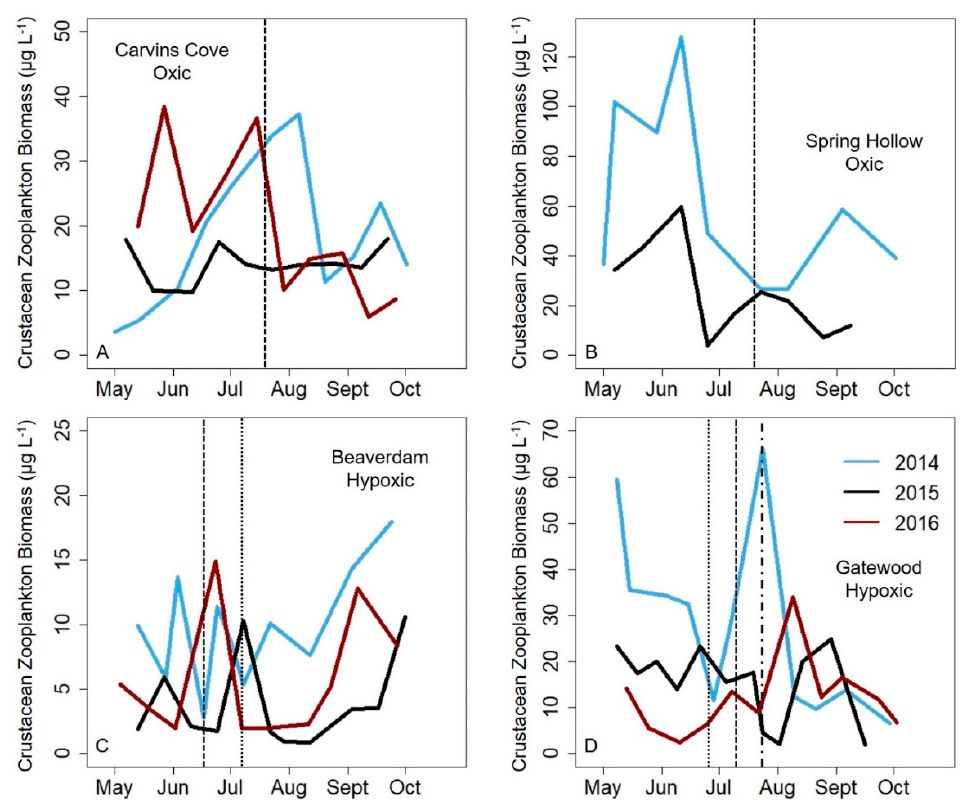
Figure 3. Seasonal dynamics of crustacean zooplankton biomass in the four reservoirs across the three years of seasonal sampling. The vertical lines denote the early and late stratified period in analyses for oxic (20 July) and hypoxic (dash: 2014; dash-dot: 2015; dotted: 2016) reservoirs. Note the different scales in biomass between the four reservoirs.